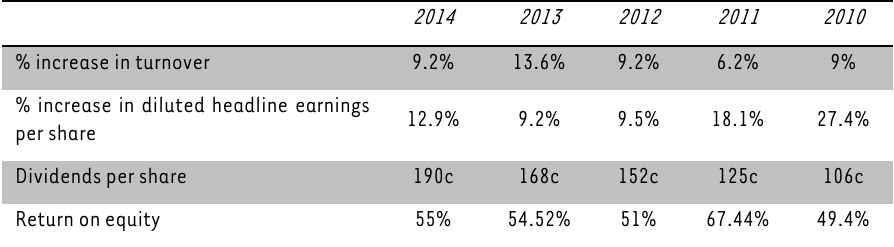
TABLE 16: Clicks performance statistics from 2010 to